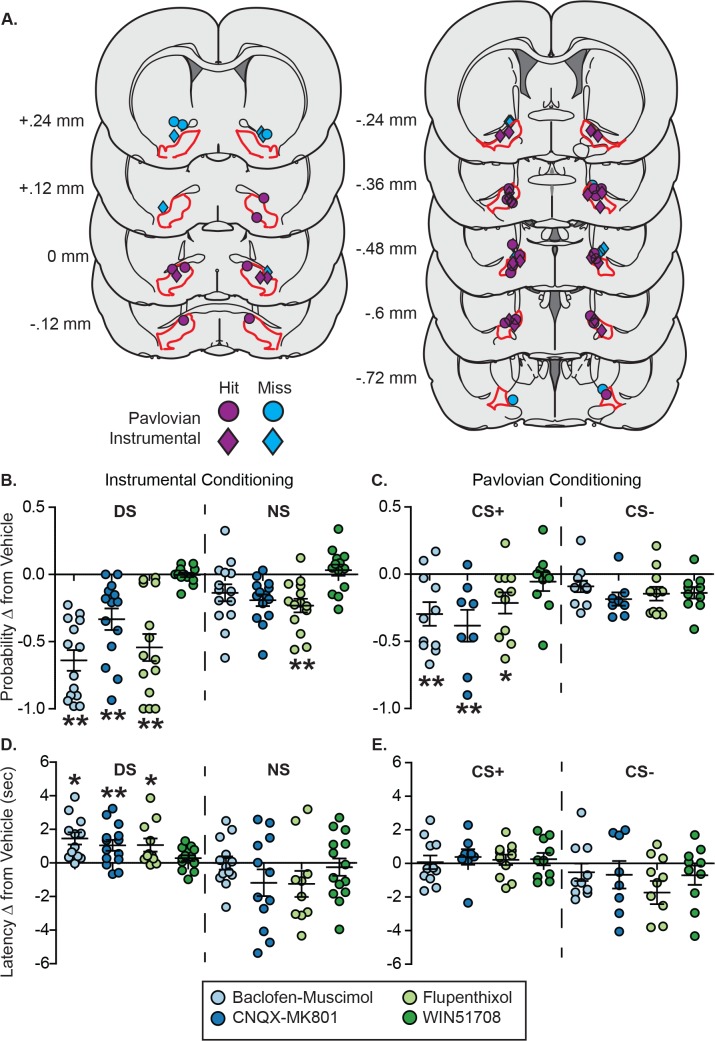
VP inactivation or disruption of local glutamate or dopamine signaling impacts reward-seeking latency after instrumental, but not Pavlovian training.(A) Histological reconstruction of microinjection sites in the instrumental task (diamonds) and in Pavlovian (circles) experiments shown on coronal slices, marked relative to bregma (mm), with the boundaries of VP demarcated in red. Purple markers indicate microinjection locations contained within VP, and blue markers indicate microinjection locations that were not contained within VP. (B) Change from vehicle in the probability of a port entry during the CS+ (left) or CS– (right) in the instrumental task, following each drug treatment. (C) Change from vehicle in the probability of a port entry during the DS (left) or NS (right) in the Pavlovian task, following each drug treatment. (D) Change from vehicle in port entry latency during the CS+ (left) or CS– (right) in the instrumental task, following each drug treatment. (E) Change from vehicle in port entry latency during the DS (left) or NS (right) in the Pavlovian task, following each drug treatment. *, p<0.05, *p<0.01 pairwise comparison with Sidak corrections.